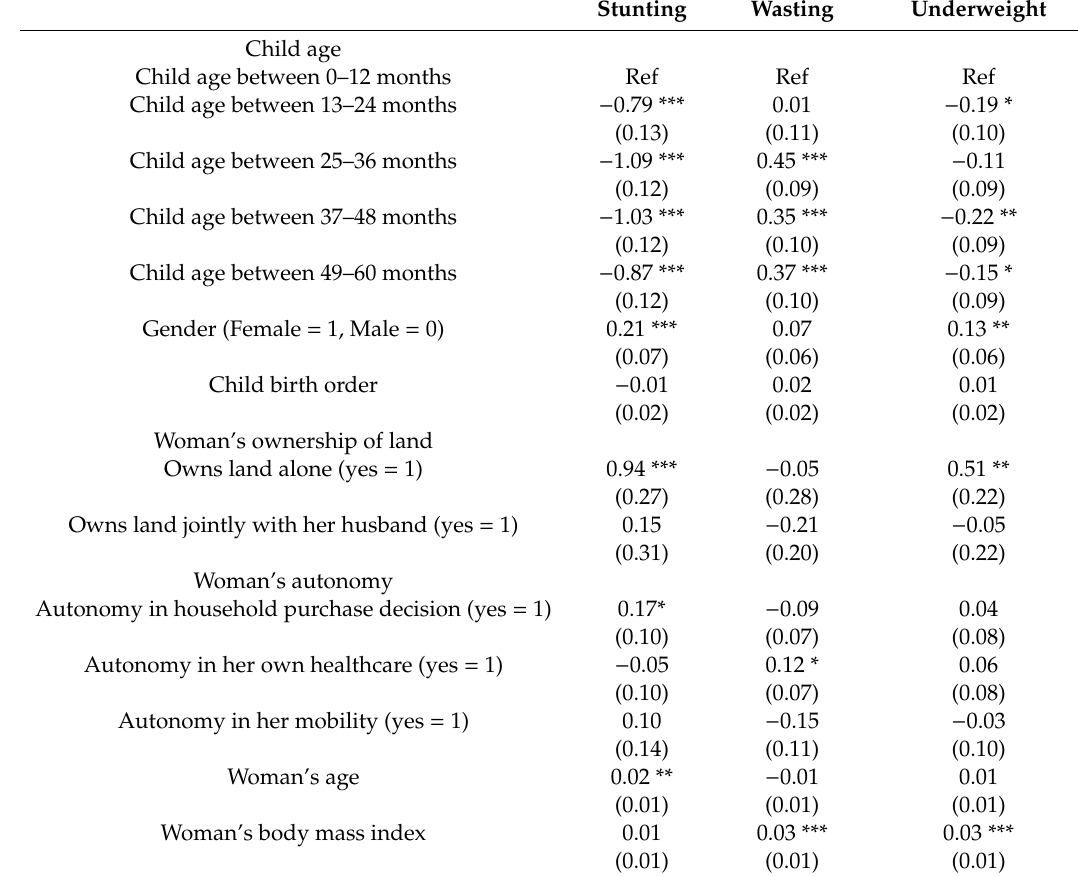
Table 3. Ordinary least squares estimates for child nutritional status. Stunting Wasting